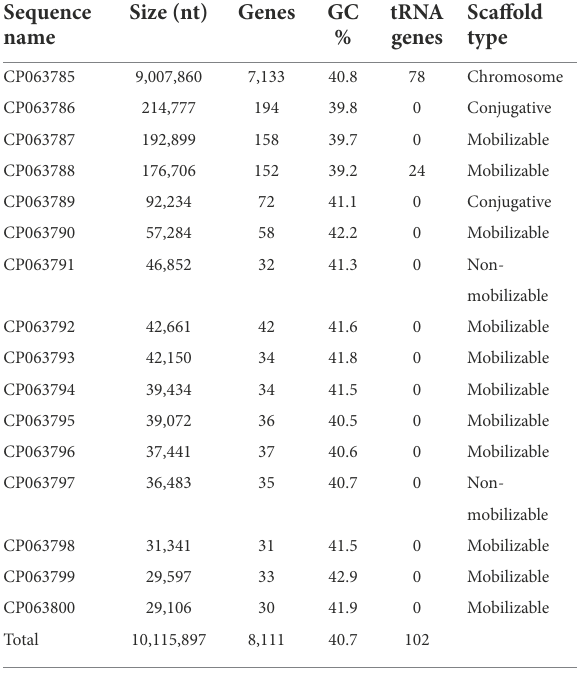
TABLE 1 Summary of the Tolypothrix sp. PCC 7712 genome as obtained from Illumina and Nanopore